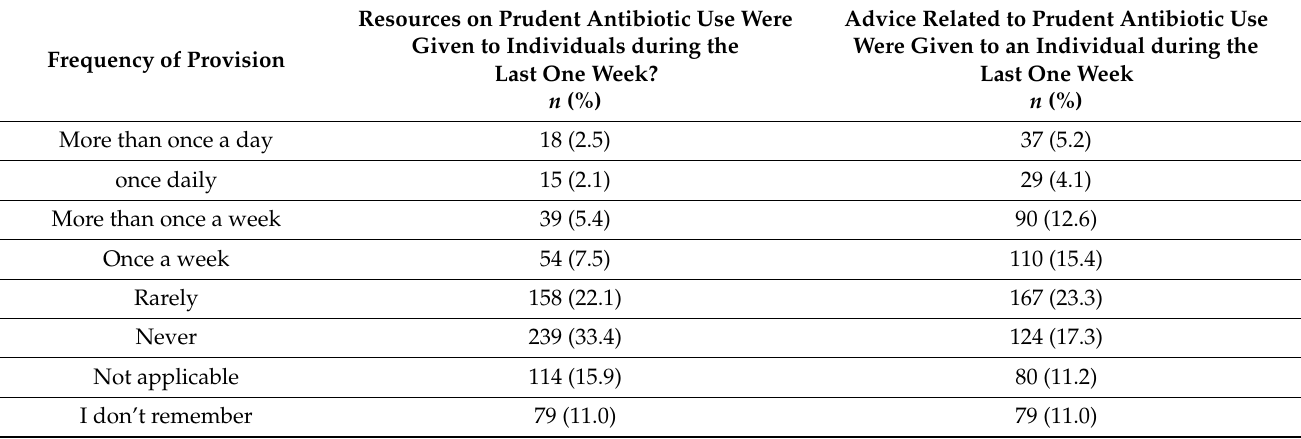
Table 5. Behavior regarding antimicrobial resistance reported by the respondent